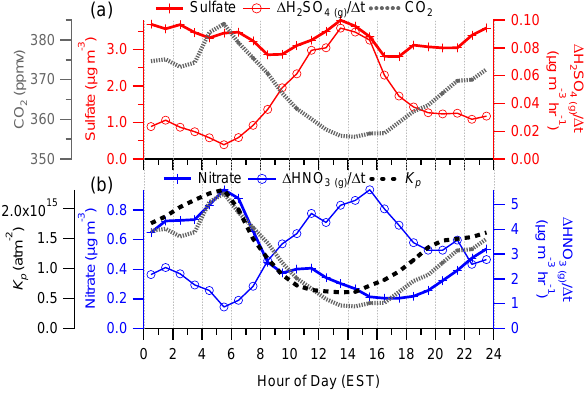
Fig. 4. Diurnal cycles of (a) sulfate, estimated gas phase production rate of H 2 SO 4 , and CO 2 and (b) nitrate, estimated gas phase production rate of HNO 3 , equilibrium constant of K p for ammonium nitrate, and CO 2 .